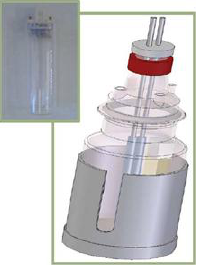
Figure 2. Electrolytic cell with the UV source.